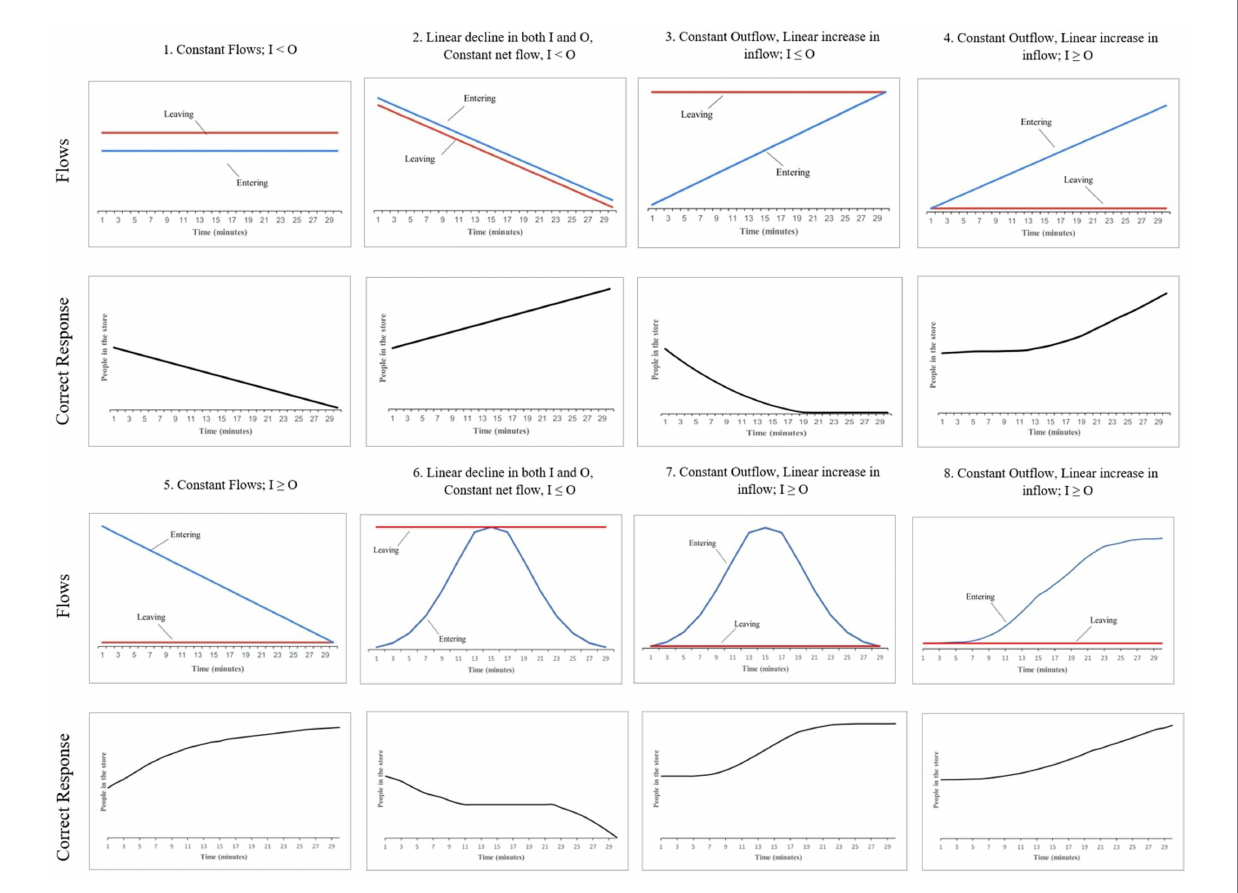
FIGURE 2 The eight stock-and-flow questions given in task 2 and the corresponding correct